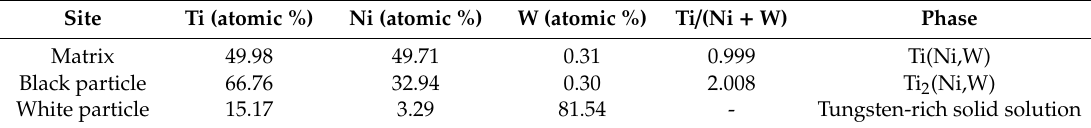
Figure 2. EPMA backscattering electron image of the as-homogenized Ti 50 Ni 49 W 1 alloy. Table 1. Composition of the as-homogenized Ti 50 Ni 49 W 1 alloy detected from Figure